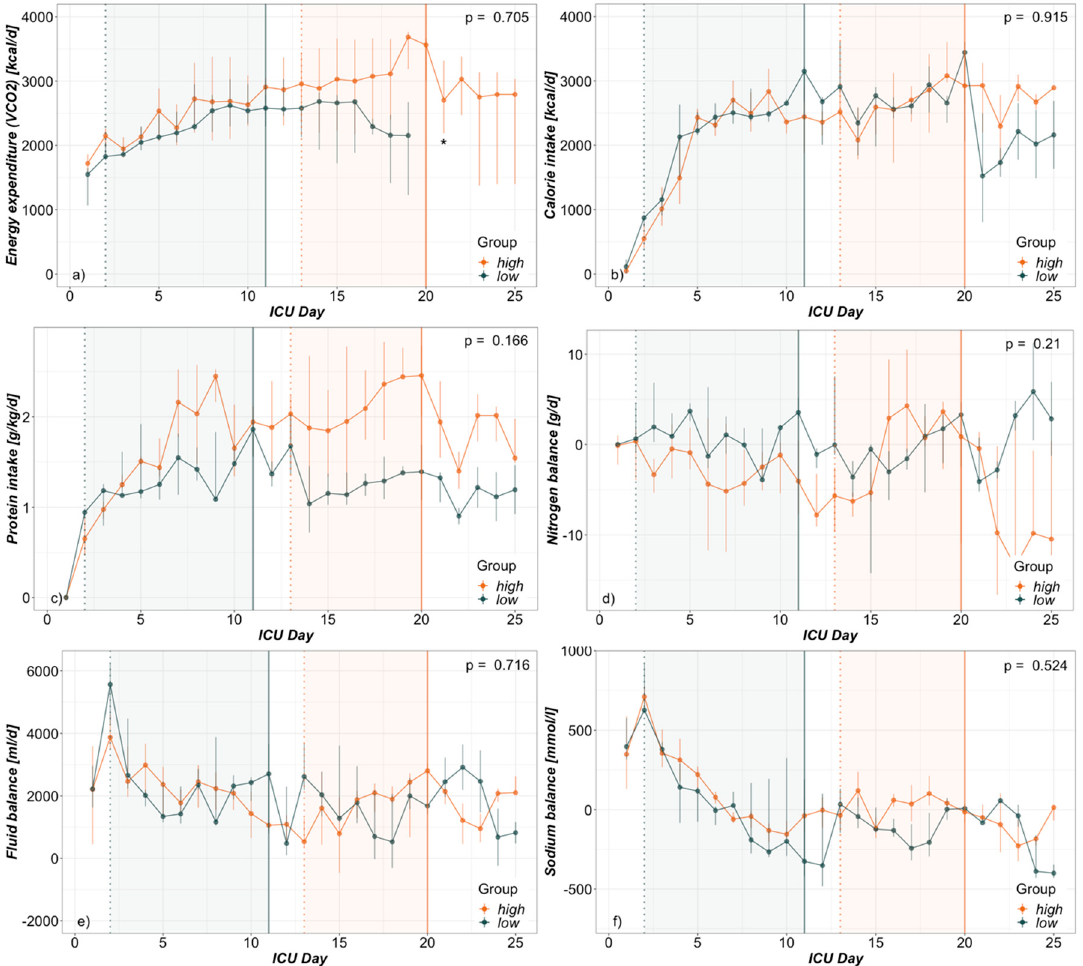
Figure 2. ICU-day dependent group analysis presented as daily median and interquartile range from admission to day 25 (day of latest NaS peak) of ( a ) Energy expenditure ( b ) Calorie intake ( c ) Protein intake ( d ) Nitrogen balance ( e ) Fluid balance and ( f ) Sodium balance. Vertical lines indicate median day of NaS peak (solid) and beginning of NaS incline (dotted). * incomplete values due to partially extubated patients.